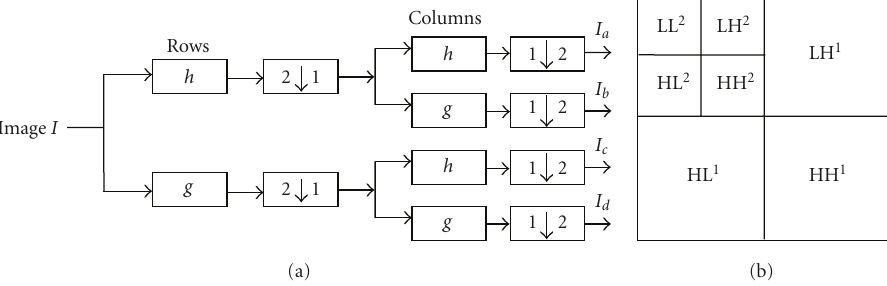
Figure 1: Structures of 2-D DWT. (a) One stage of 2-D DWT multiresolution image decomposition; (b) 2-D DWT structure with labeled subbands in two-level